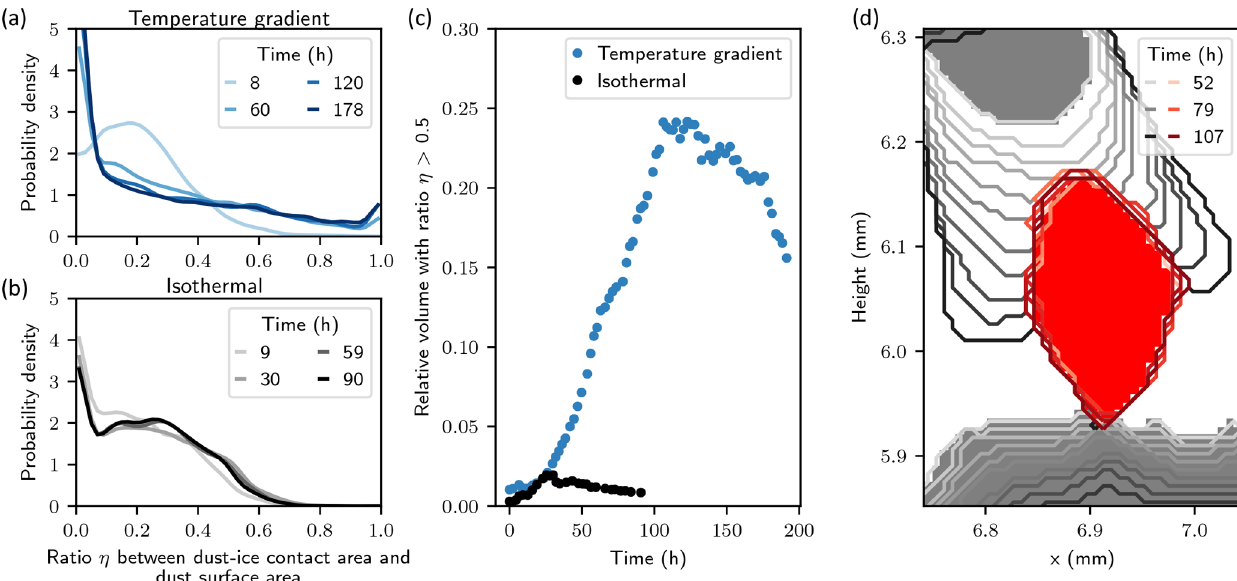
Figure 3. Dust inclusion in the ice matrix. (a, b) Distribution of the ratio η between the dust–ice contact area and the dust surface area. The probability density is expressed in terms of number of particles and is computed with bins of width 0.02µmh − 1 . (c) Time evolution of the relative volume of dust particles that share more than 50% of their surface with ice. (d) Example of the dust progressive inclusion in the ice matrix in the temperature gradient experiment. The initial location of ice is shown in solid gray. The initial location of dust is shown in solid red. Their time evolutions are shown by the different contours.